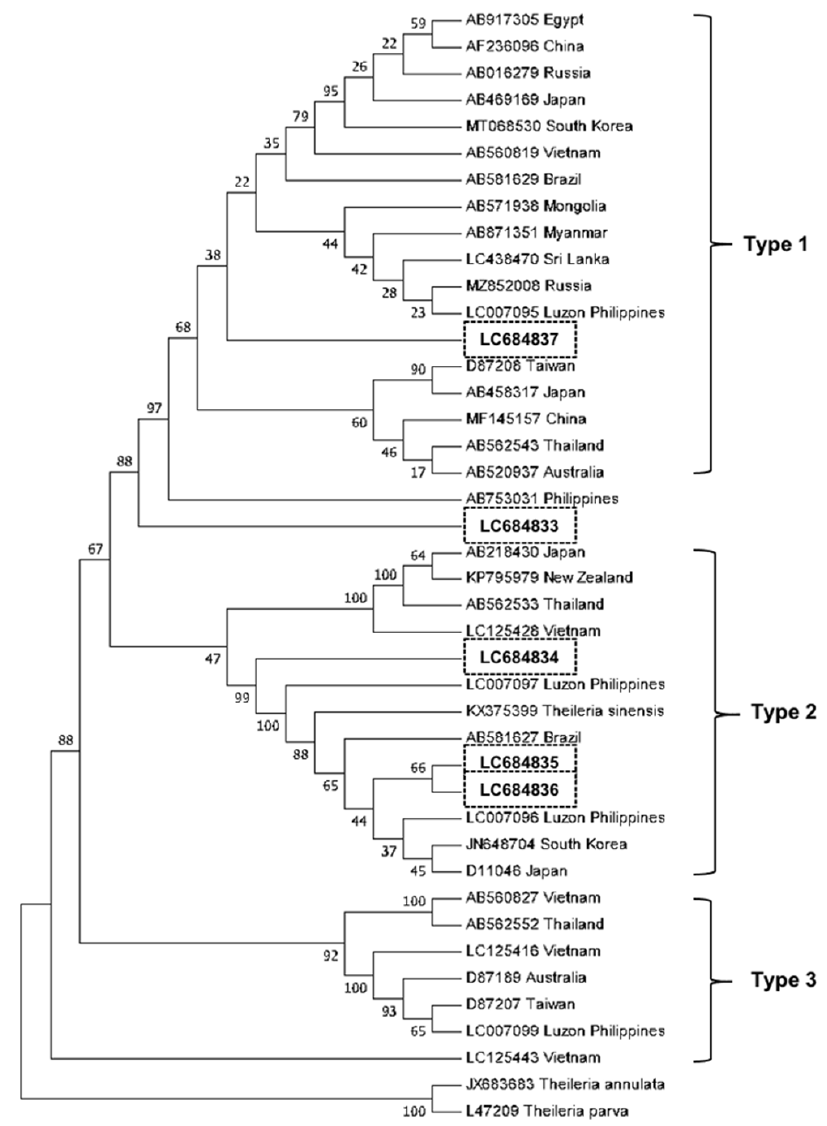
Figure 3. Phylogenetic tree for Theileria orientalis based on major piroplasm surface protein. Neighbor-joining method based on Kimura’s two-parameter substitution model was employed. The numbers next to the branches indicate the percentage of replicate trees based on 1000 bootstrap replicates. The isolates from this study are enclosed in boxes.